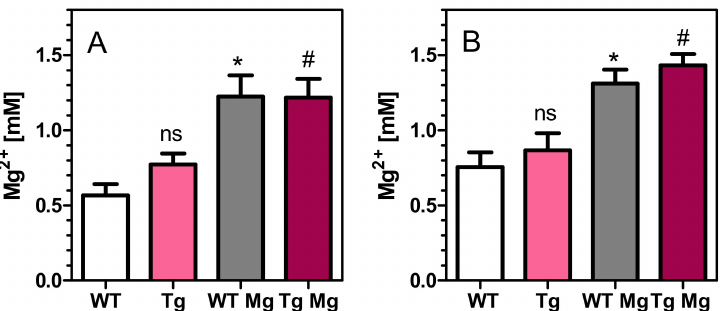
Figure 6. Extracellular concentrations of magnesium (not corrected for recovery) as determined by microdialysis. ( A ) Young (6–7 month old) rats. ( B ) Old (15–16 month old) rats. Magnesium levels were measured in untreated wild-type and transgenic rats (WT, Tg) and after treatment with magnesium orotate (WT Mg, Tg Mg). Data are means ± SEM ( n = 4–19) and were analysed by one-way ANOVA followed by Bonferroni’s multiple comparison test: ( A ) F 3,46 = 5.82, p < 0.01. ( B ) Old rats: F 3,46 = 11.71, p < 0.001. ns, not significant vs. WT. * p < 0.05 vs. WT rats. # p < 0.05 vs. Tg rats.